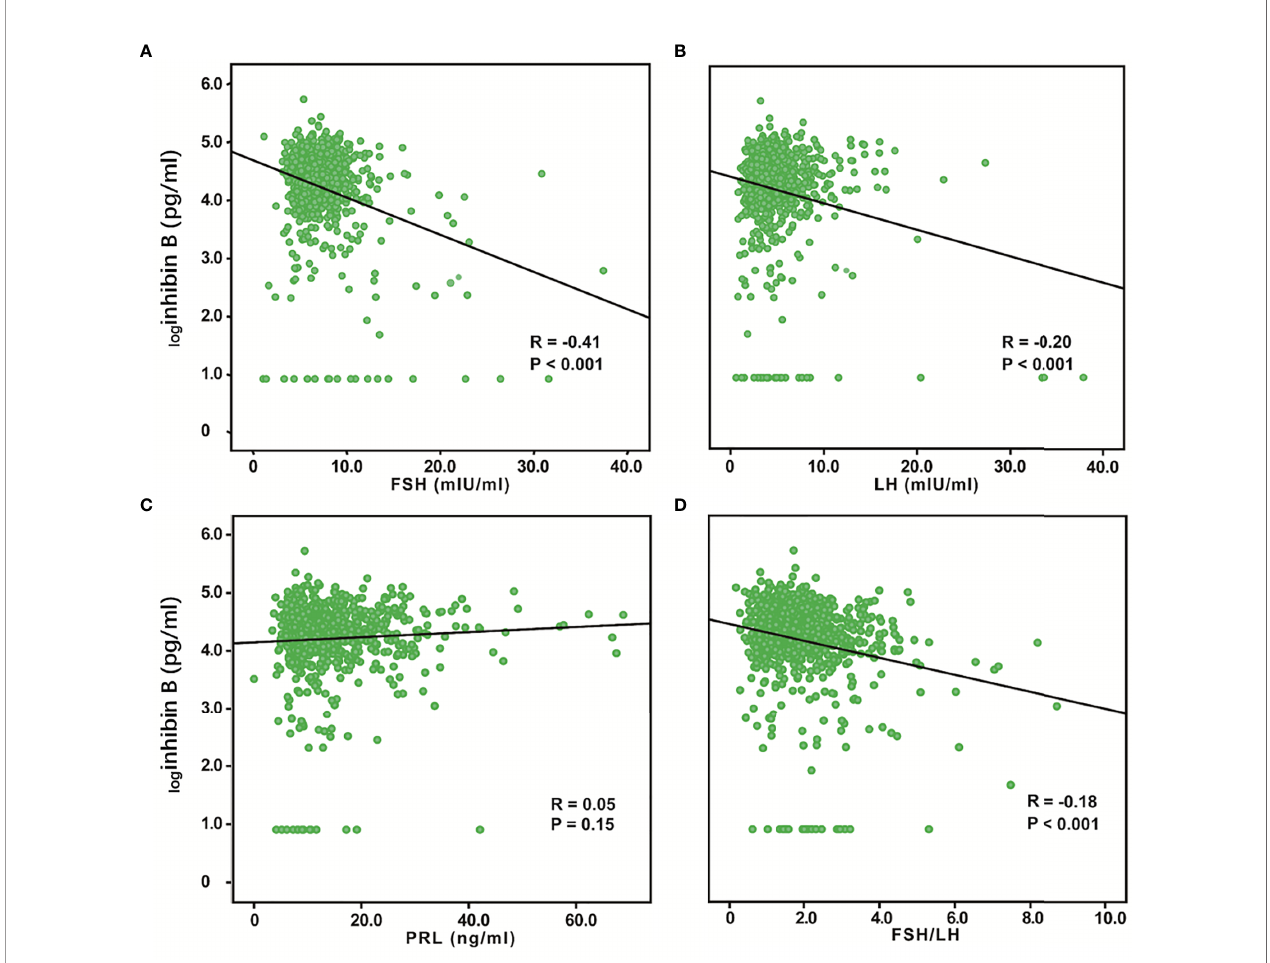
FIGURE 3 | Relationship between serum inhibin B levels and FSH, LH, PRL, and FSH/LH. log Inhibin B was signi fi cantly negatively correlated with FSH (R = -0.41, P < 0.001) (A) and LH (R = -0.20, P < 0.001) (B) . No correlation was found between logInhibin B and PRL (R = 0.05, P =0.15) (C) . log Inhibin B was signi fi cantly negatively correlated with FSH/LH (R = -0.18, P < 0.001) (D)